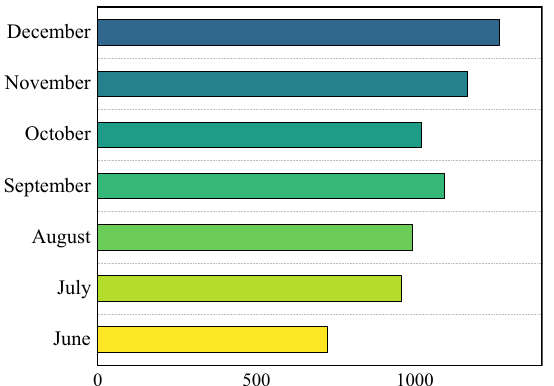
Fig. 8 The fault record number of each month